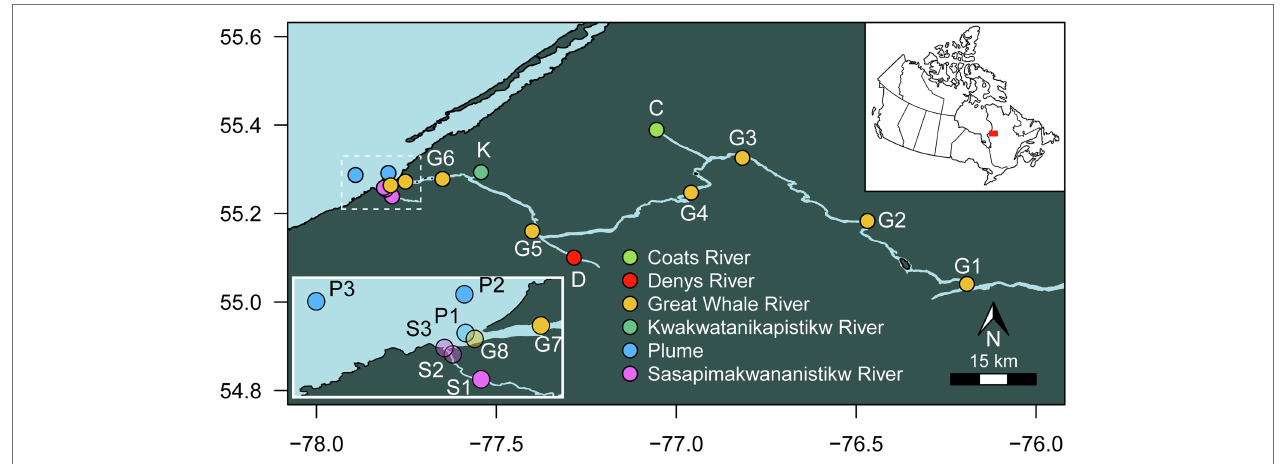
FIGURE 1 | Location of the sampling